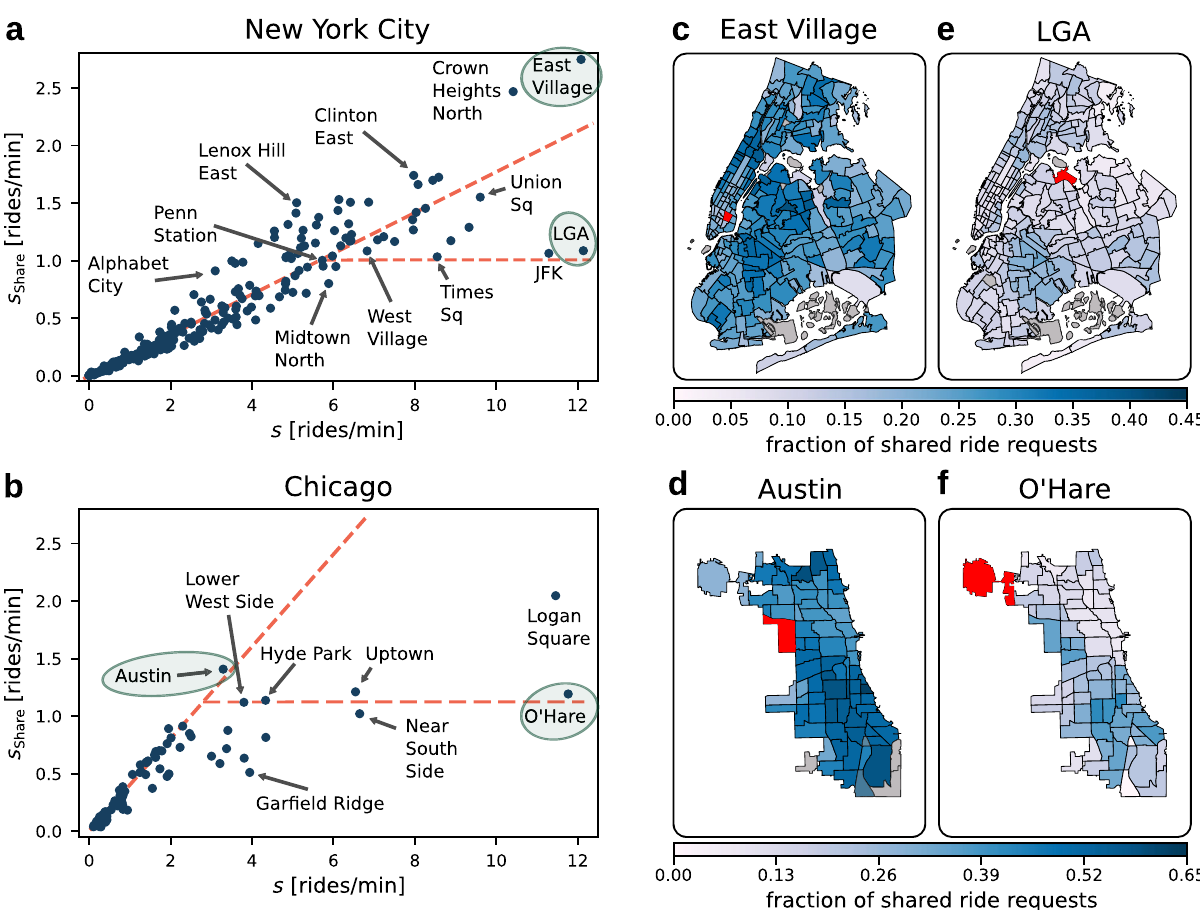
Fig. 5 Ride-sharing adoption in New York City and Chicago is consistent with the predicted high- and low-sharing regimes. a , b Sharing decisions for New York City and Chicago (blue dots) distribute between the two branches corresponding to the high- and low-sharing regime, consistent with the model predictions under heterogeneous user preferences (compare Fig. 4). At low request rates, the number of requests for shared rides increases linearly with the total number of requests (compare red diagonal). At high request rates, the sharing decisions differ between locations (compare Figs. 1 and 4, see also Supplementary Note 1 and 2). As inconvenience preferences ζ are naturally heterogeneous in the cities, adoption is in a hybrid low/high-sharing state. c – f Ride-sharing adoption is consistently higher across destination zones in the high-sharing regime compared to the low-sharing regime. The predominantly linear increase of the number of shared rides in New York City as demand increases suggests broadly suf fi cient fi nancial compensation of sharing disutilities, or, alternatively a very broad range of user preferences, leading to a stable fraction of ride-sharing adoption. However, the slope of the high- sharing branch indicates that only about 20% of ride-hailing users consider ride-sharing as an option. While about 40% of requests are shared in the high- sharing regime in Chicago, this potential is largely not realized. The available data points at locations with relatively high request rate indicate a growth with the request rate that is much weaker than on average for the entire data set, or even absent, consistent with the low-sharing regime observed in our model. Seven large downtown zones in Chicago with up to 50 requests per minute (not shown) fall in between the high- and low-sharing state, likely representing the average of sharing behavior over a diverse population of ride-hailing users as expected for users with heterogeneous preferences (see Supplementary Fig. 6 for